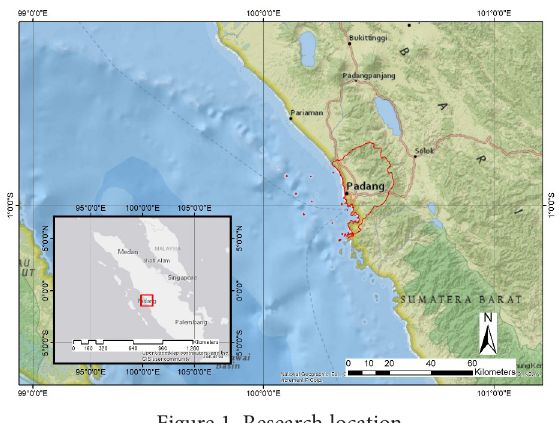
Figure 1. Research location